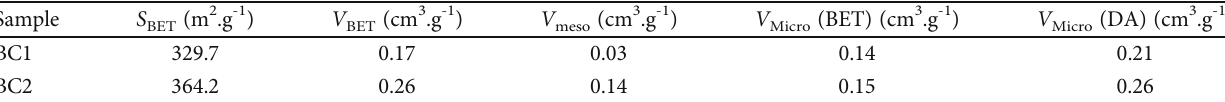
Figure 10: BET-plot (a) and adsorption/desorption isotherm (b) of BC1 and BC2 in N Table 3: Parameters of speci fi c surface area and pore of